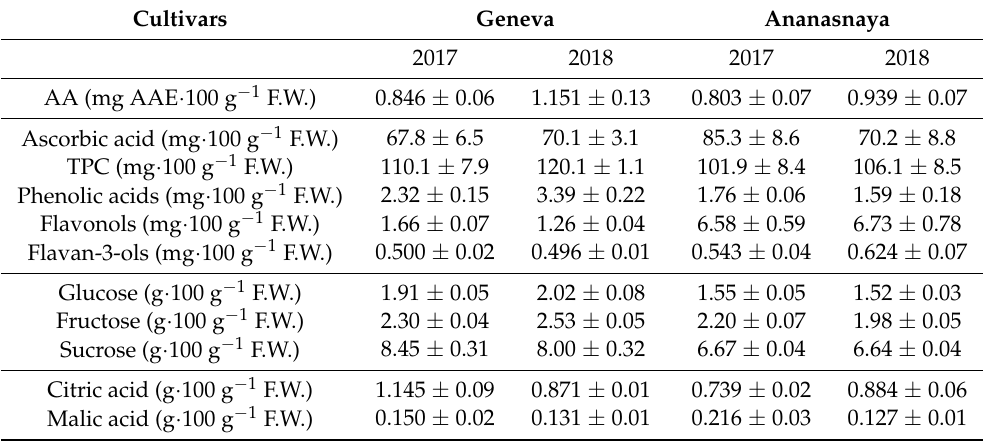
Table 1. Characteristics of ‘Geneva’ and ‘Ananasnaya’ fruit assessed directly after harvest. Cultivars Geneva